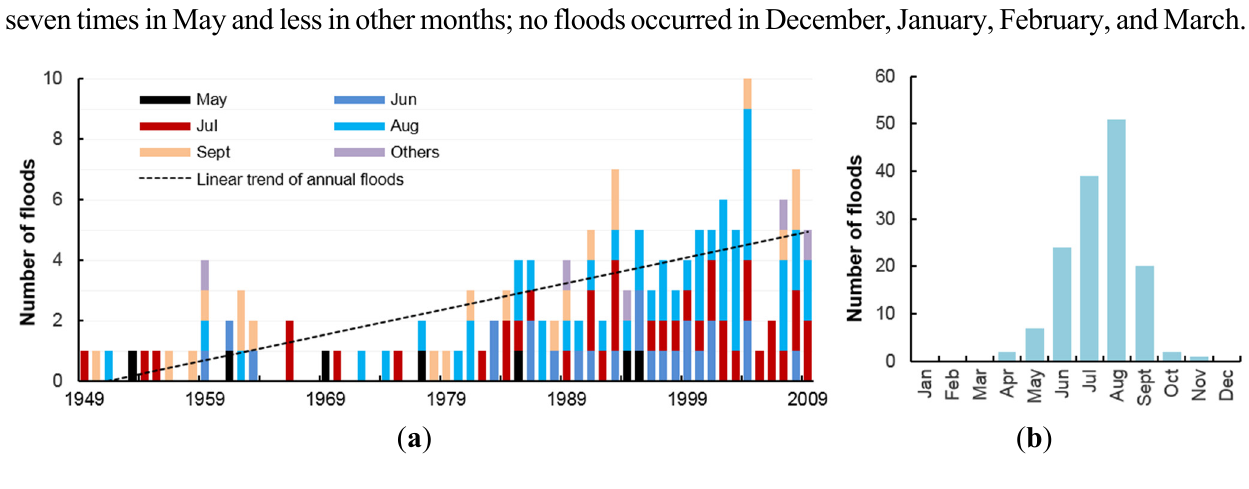
Figure 3. Stacked monthly flood frequencies per year ( a ) and the overall histogram ( b ) in Shanghai between 1949 and